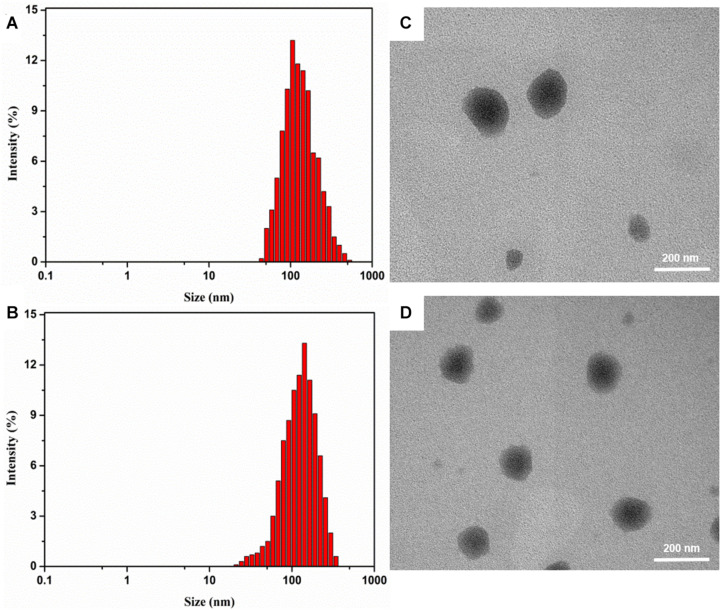
The size distribution and TEM result of DSPE-PEG@ICG (A, B) and DSPE-PEG-RGD@ICG (C, D).